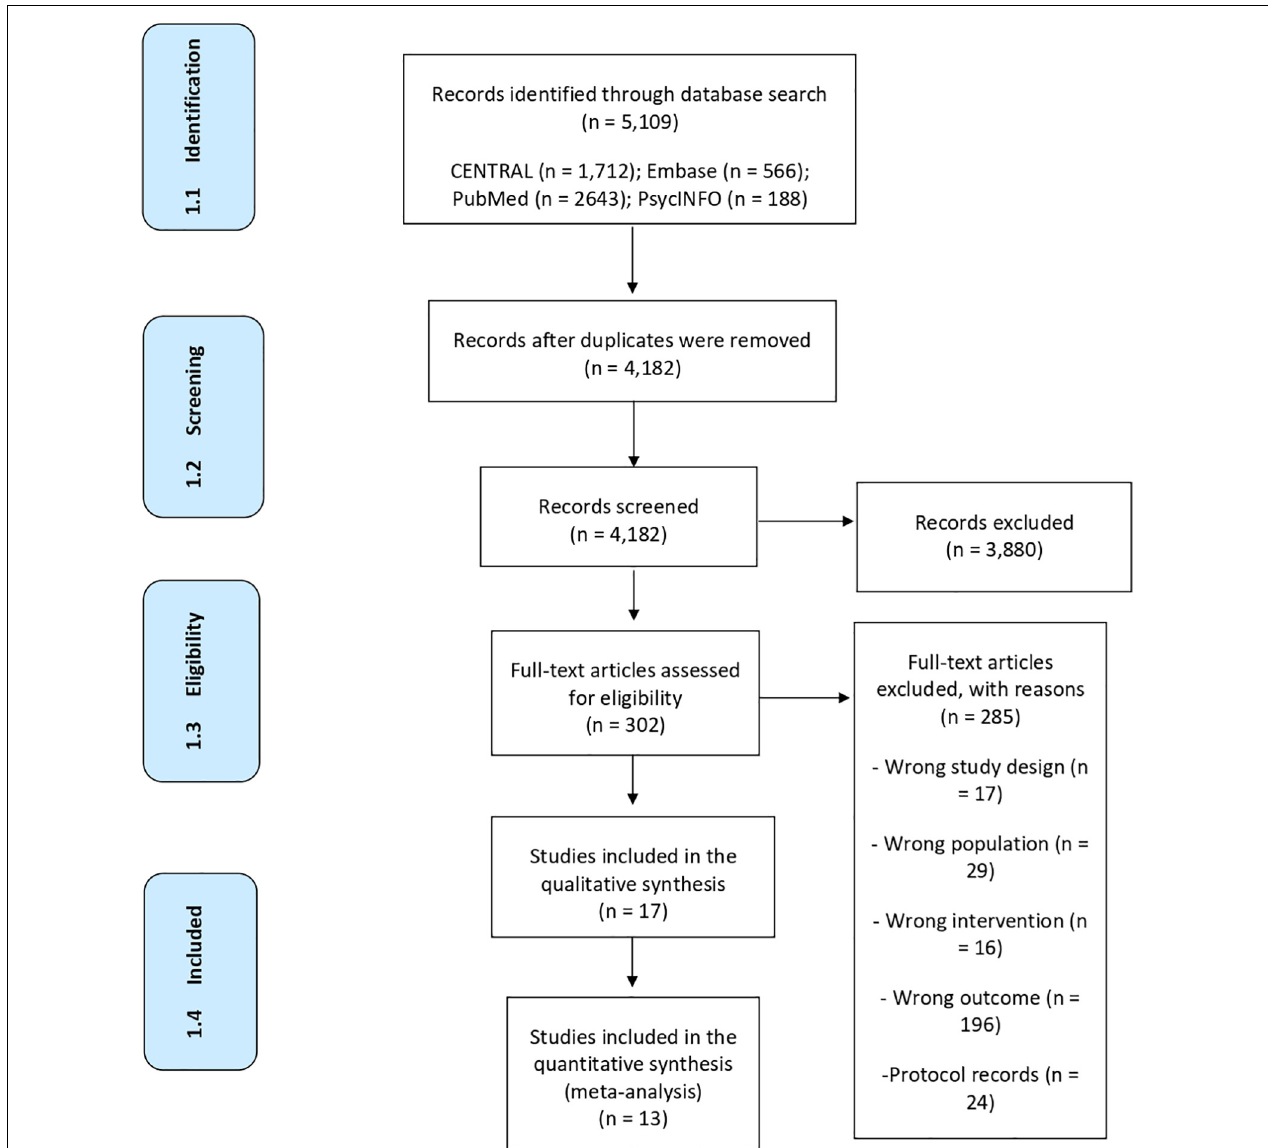
FIGURE 1 | Study flow